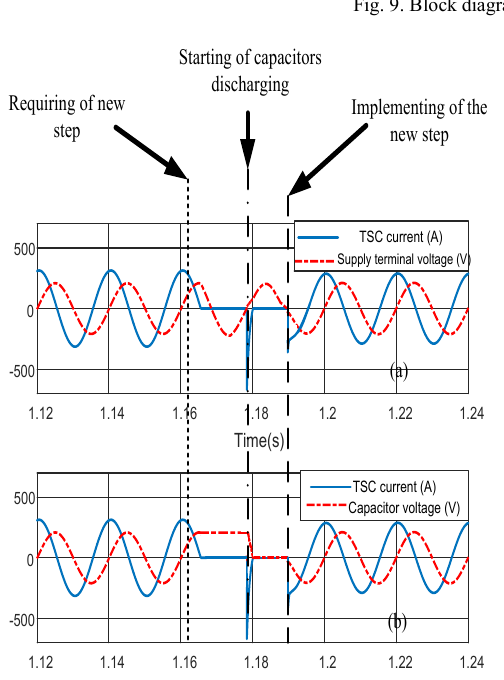
Fig. 11. Discharging process for capacitor of TSC with regeneration of energy (a) the supply voltage, (b) the supply current and (c) the capacitors